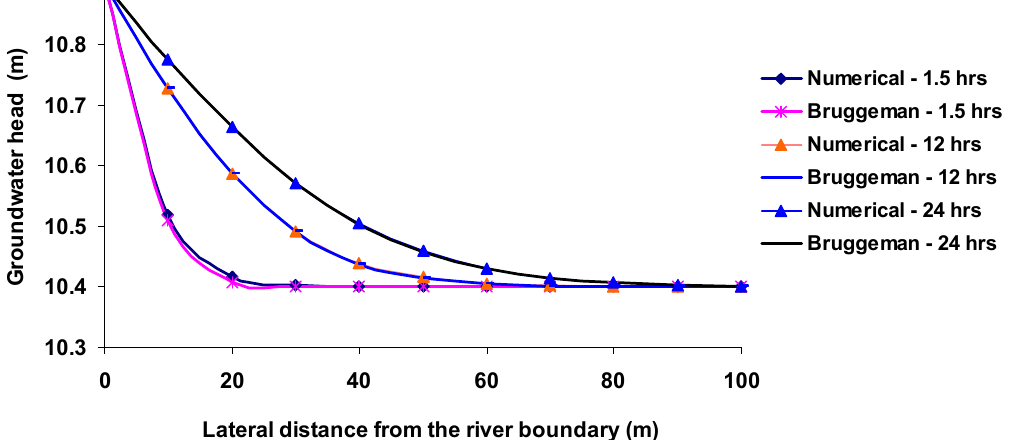
Figure 5. Groundwater head versus lateral distance from river at specific times for numerical and Bruggeman [33] solutions for a confined aquifer.